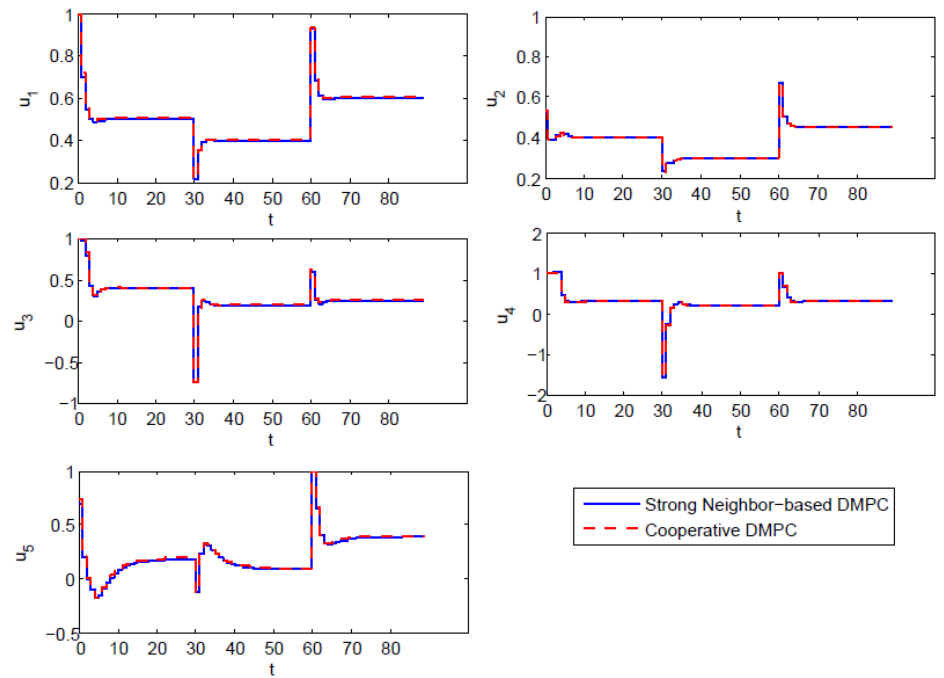
Figure 3. Inputs of each subsystem under the control of SCN-DMPC and cooperative